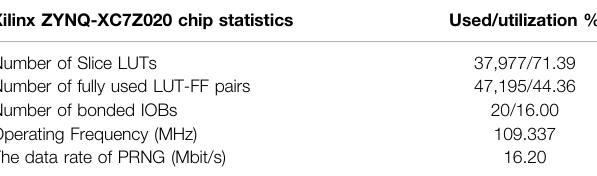
TABLE 1 | Chip Statistics of PRNG with feedback controller based on Hop fi eld neural network chaotic oscillator. Xilinx ZYNQ-XC7Z020 chip